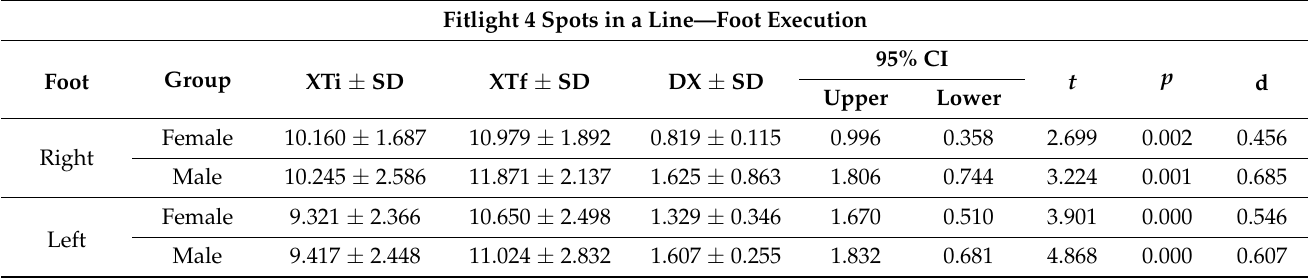
Table 2. Descriptive statistics of the Fitlight test 4 spotlights in a line—foot execution. Fitlight 4 Spots in a Line—Foot